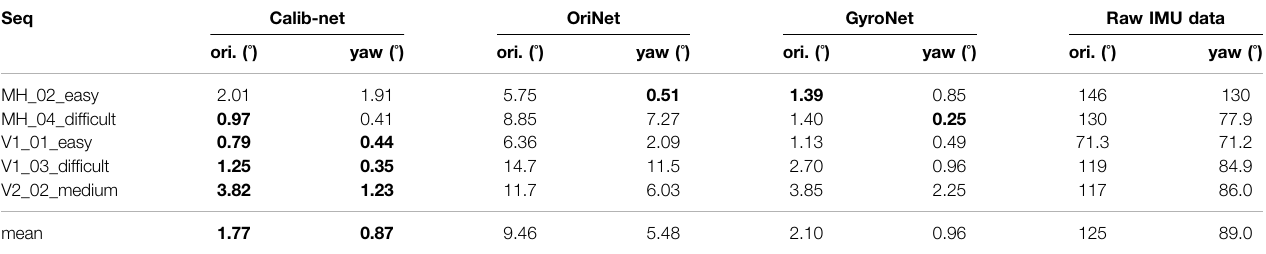
TABLE 1 | Orientation estimation results of different learning-based methods. The networks shown in the table are all trained using same sequences of the EuROC dataset (Burri et al., 2016). Both 3D orientation and yaw estimation results are given in the table. The best results are made in bold. Seq Calib-net